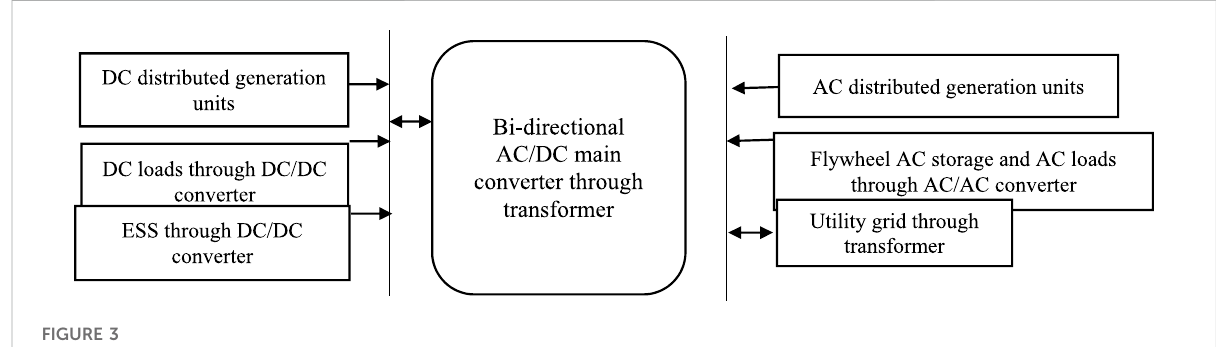
FIGURE 3 Layout of hybrid AC/DC microgrid system (Jain and Raju, 2013).